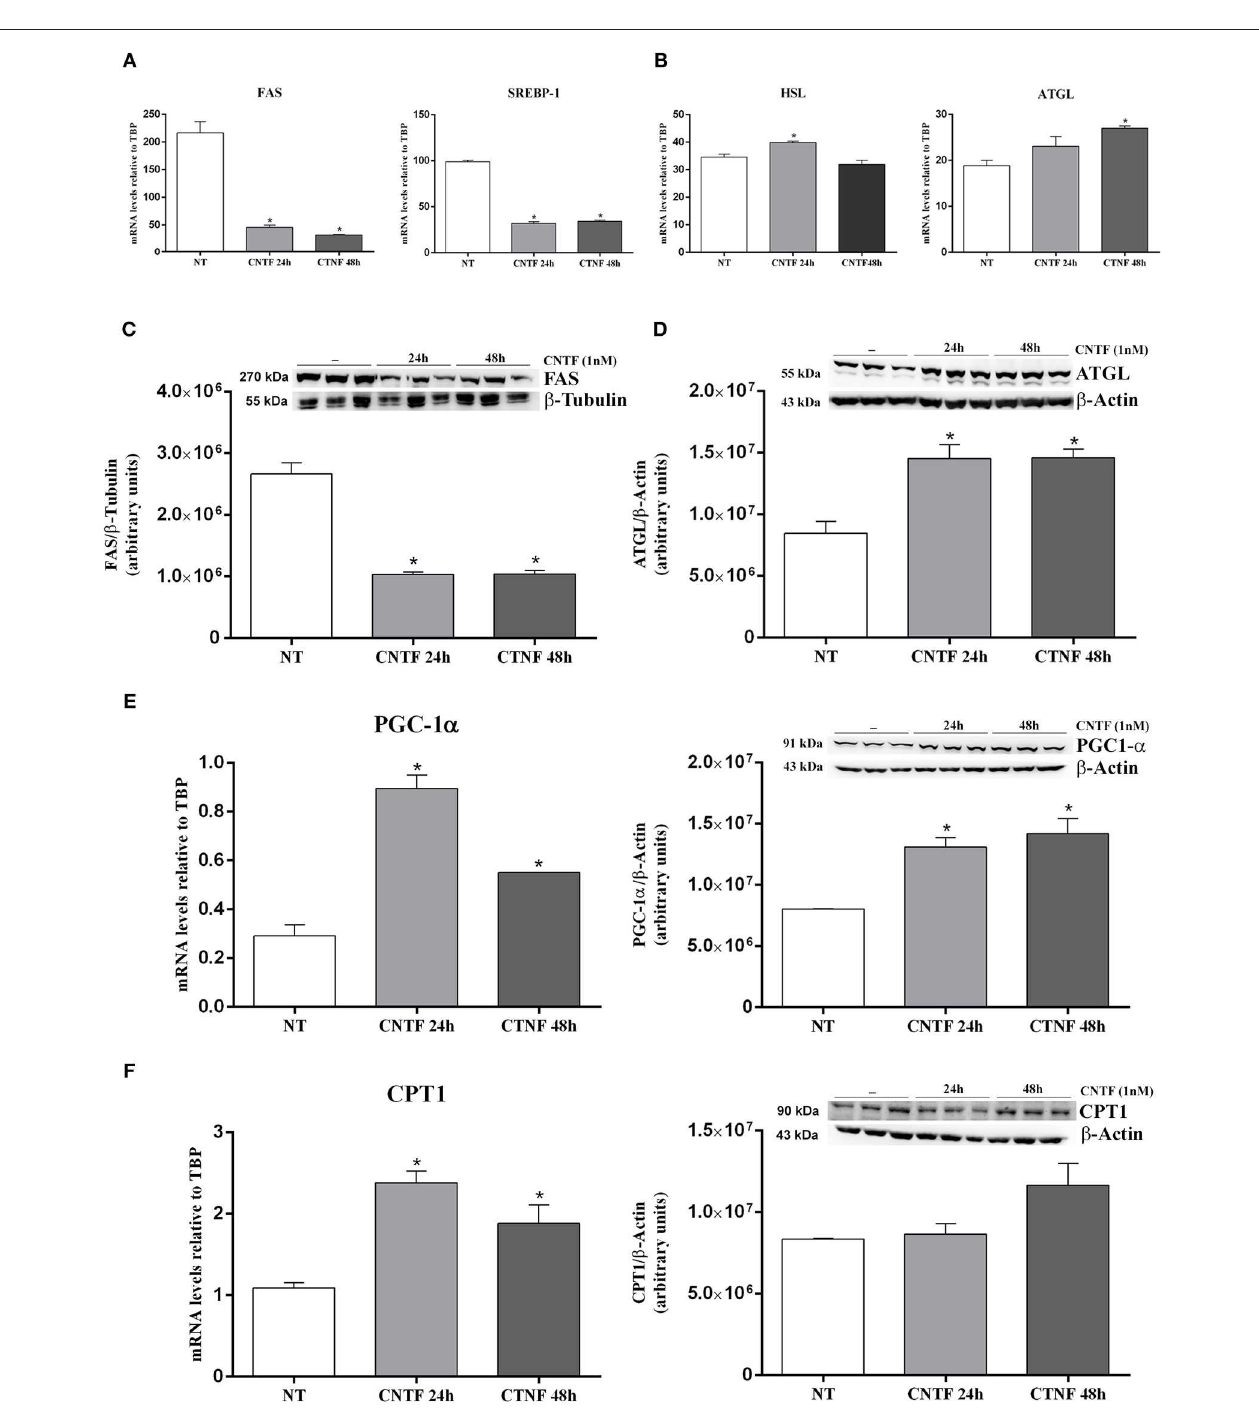
FIGURE 4 | Transcriptional changes induced by long-term CNTF treatment in hMADS adipocytes. mRNA levels of SREBP-1 and FAS lipogenic markers (A) and HSL and ATGL lipolytic enzymes (B) in hMADS adipocytes treated with 1nM CNTF for 24 or 48h. Data ( n = 3) are mean ± SEM, * p < 0.05 compared with untreated cells (NT). Data were analyzed using one-way ANOVA. Representative immunoblots and quantitative analyses of FAS (C) and ATGL (D) protein expression in hMADS adipocytes treated with 1nM CNTF for 24 or 48h. Data ( n = 3) are mean ± SEM, * p < 0.05 compared with untreated cells (NT). Data were analyzed using Student’s t -test. (E) PGC-1 α mRNA and representative immunoblot and protein quantification in hMADS adipocytes treated with 1nM CNTF for 24 or 48h. Data ( n = 3) are mean ± SEM, * p < 0.05 compared with untreated cells (NT). Data were analyzed using one-way ANOVA. (F) CPT1 mRNA and representative immunoblot and protein quantification in hMADS adipocytes treated with 1nM CNTF for 24 or 48h. Data ( n = 3) are mean ± SEM, * p < 0.05 compared with untreated cells (NT). Data were analyzed using one-way ANOVA.